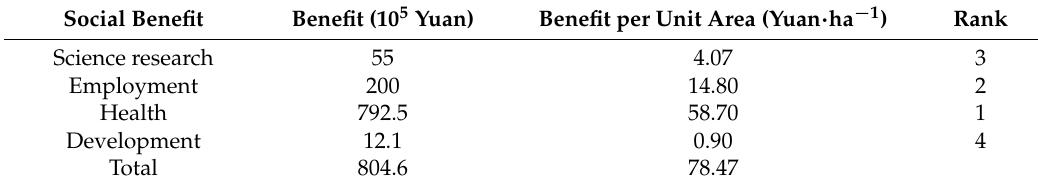
Table 4. Social benefit in Yanqing District in 2014.